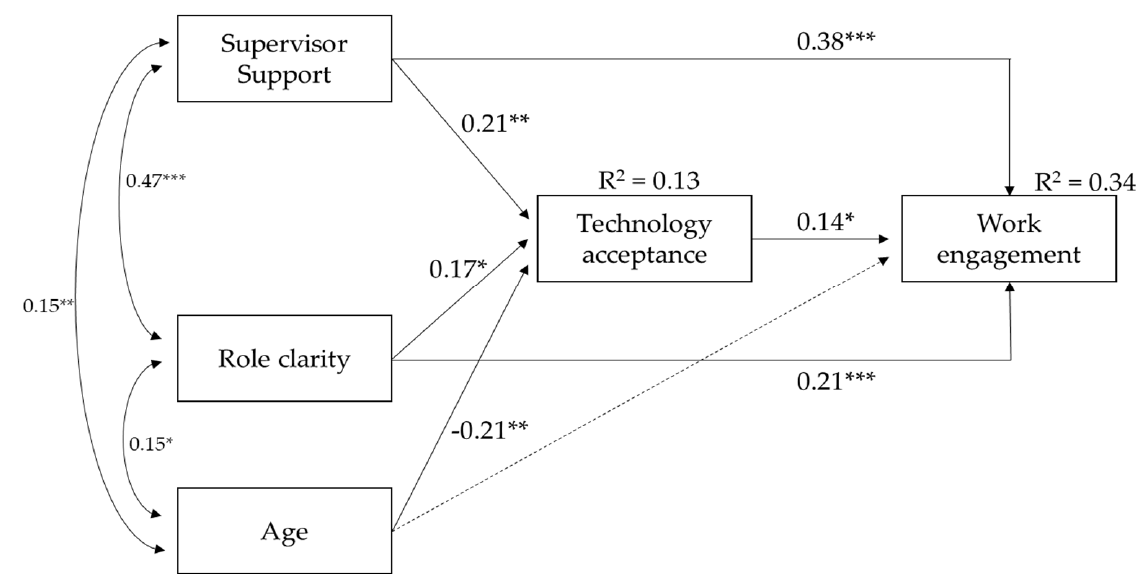
Figure 2. The final model (standardized path coefficients). Discontinuous lines indicate non-significant relationships. *** p < 0.001; ** p < 0.01; * p < 0.05. Table 2. Indirect effects using bootstrapping (2000 replications). Indirect Effects